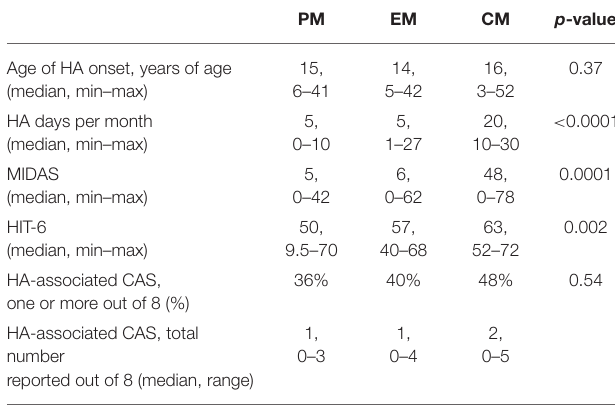
TABLE 2 | Migraine group clinical